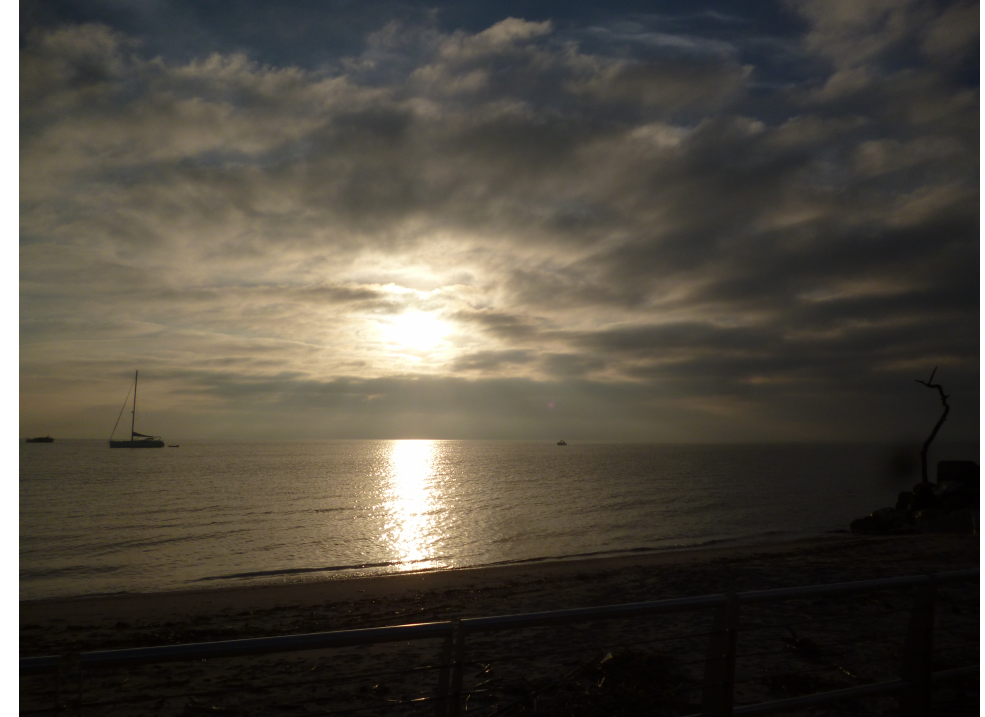
FIG. 4: Early morning view taken east of the Giens peninsula in Southern France